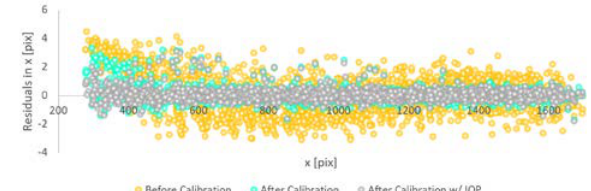
Figure 9: x-image residuals as a function of their column number in the image